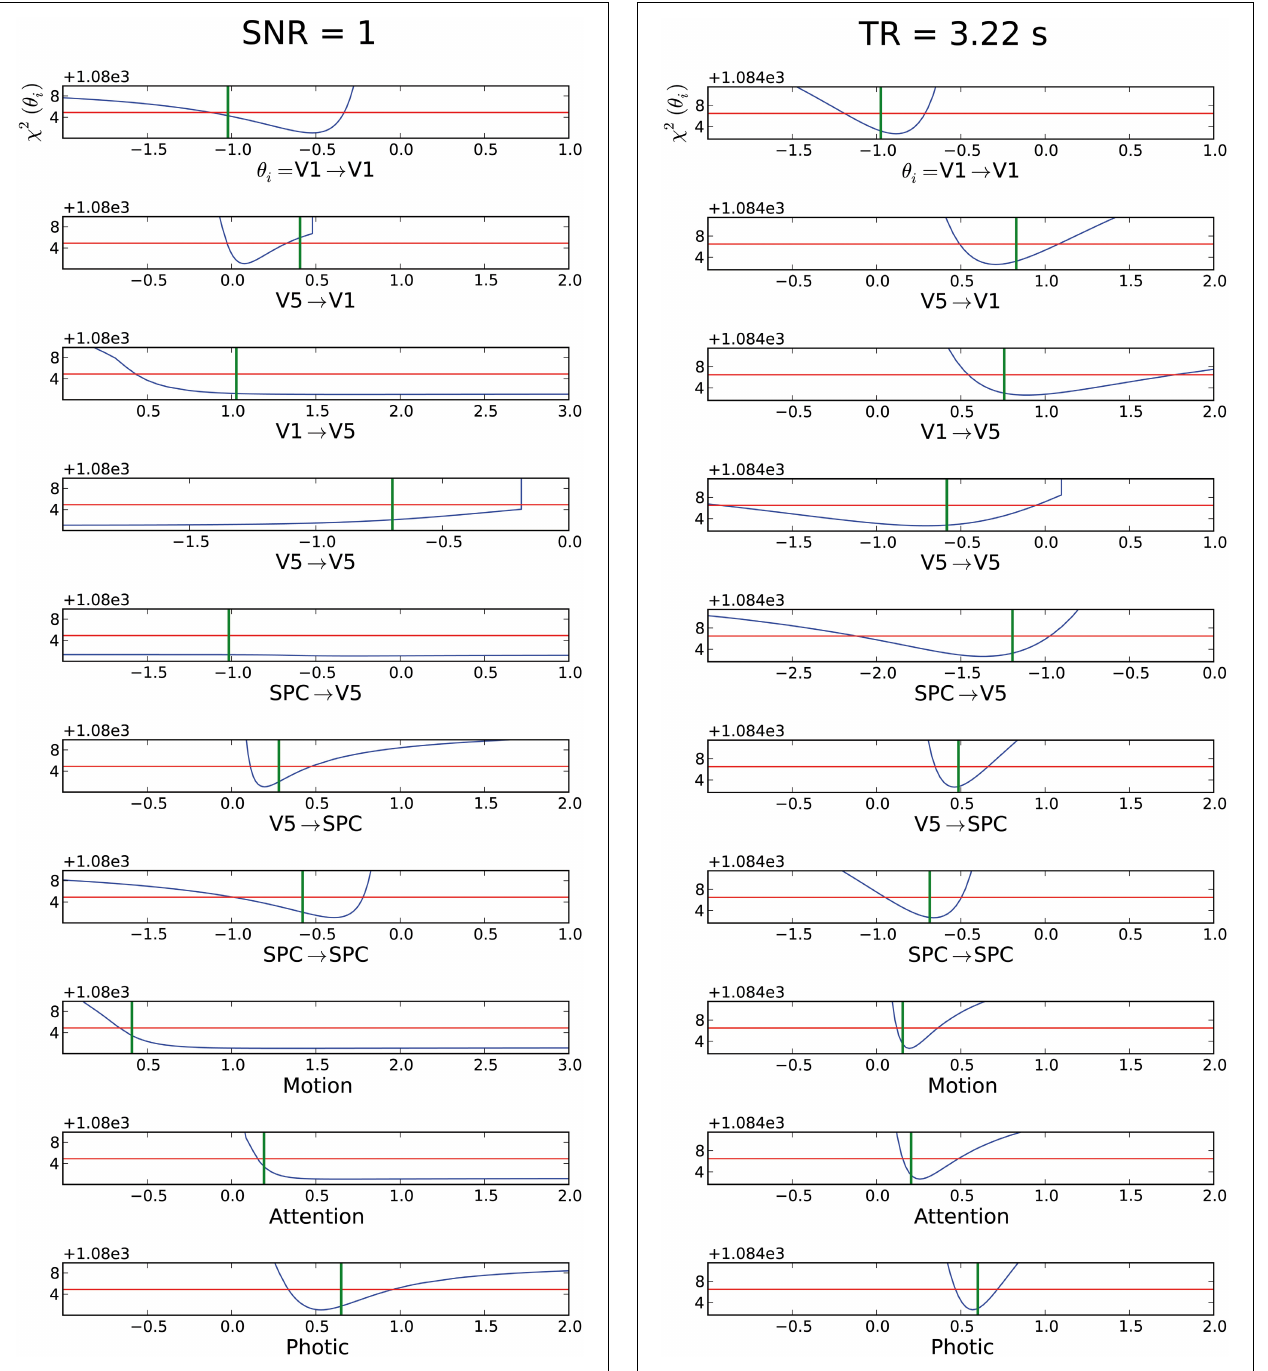
FIGURE 5 | Assessment of data with an SNR = 1, where mCI = ∞ . For explanation of the graphs see Figure 2 .